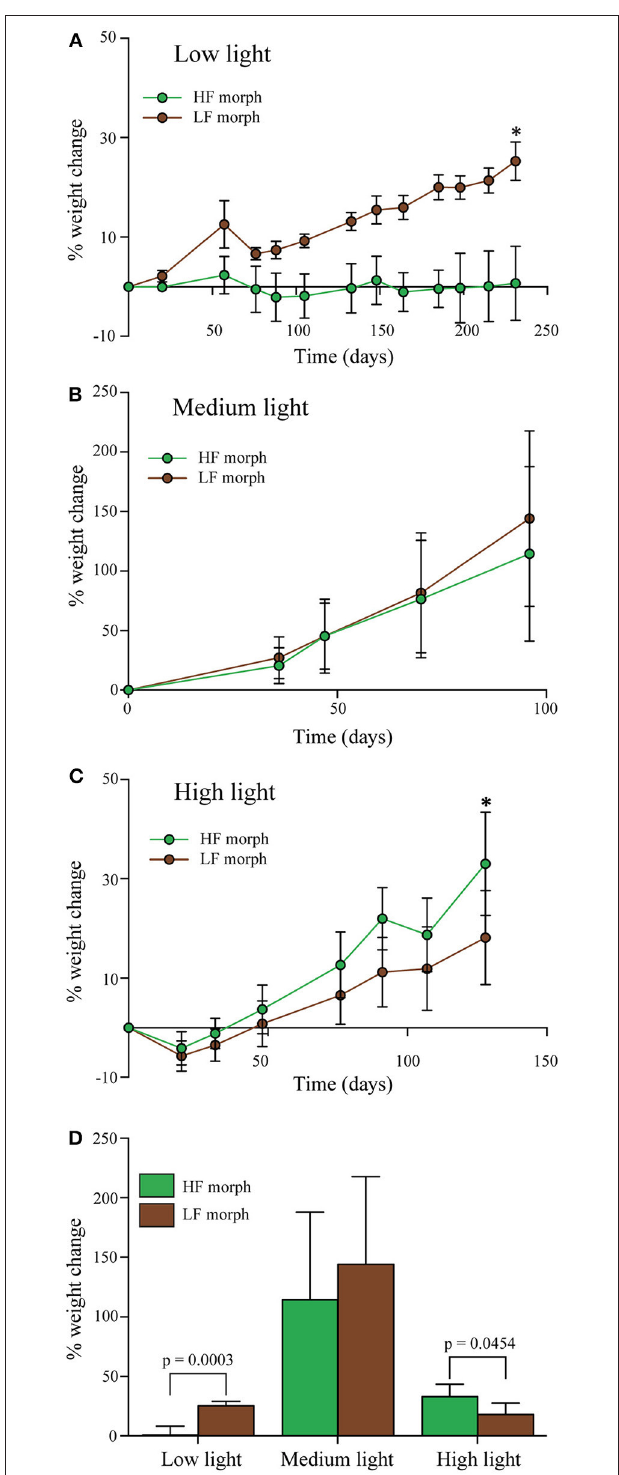
FIGURE 3 | (A–C) Percentage change of wet weight of LF morph (brown circles) and HF morph (green circles) of Hydnophora grandis over time under three different intensities of blue light. (A) Low light (10 µ mol photons m − 2 s − 1 ), (B) Medium light (300 µ mol photons m − 2 s − 1 ), and (C) High light